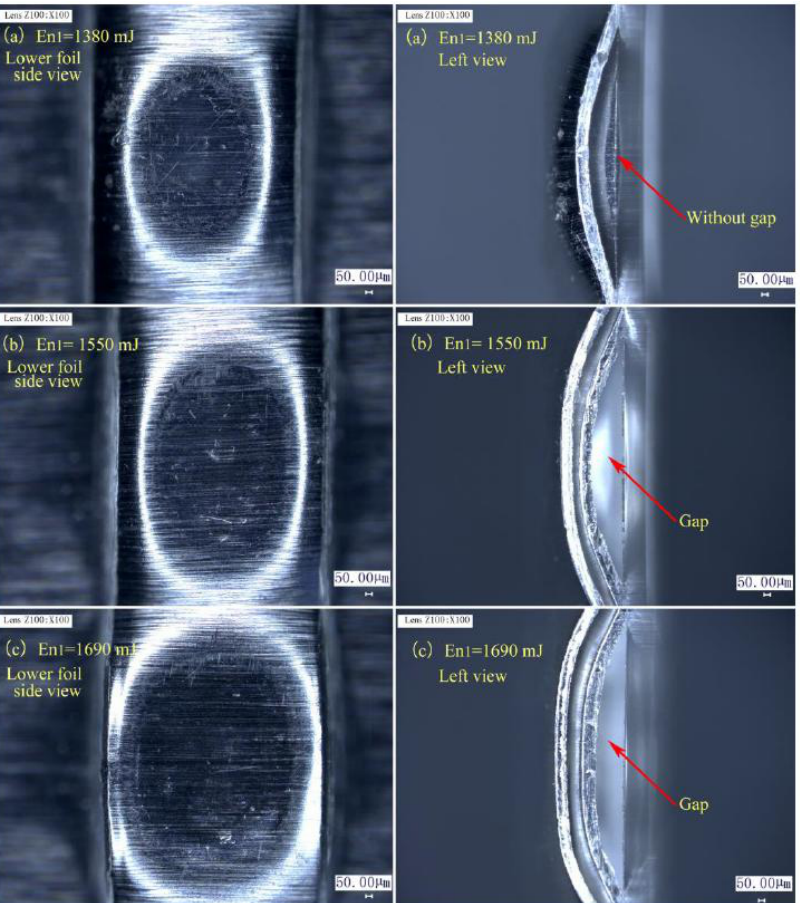
Figure 20. Preliminary joints produced under H of 500 µ m and three di ff erent En 1 : ( a ) En 1 = 1380 mJ; ( b ) En 1 = 1550 mJ; ( c ) En 1 = 1690 mJ.